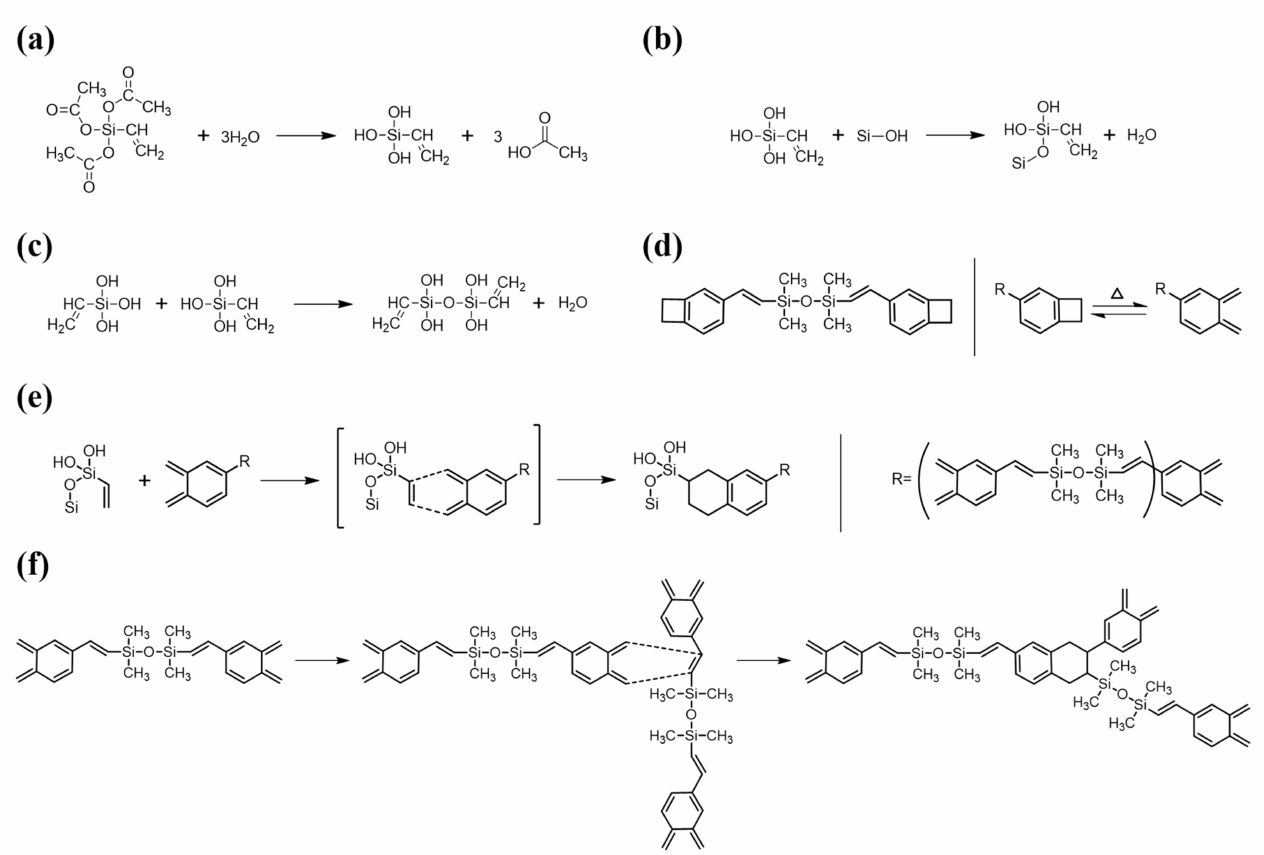
Figure 2. Reaction mechanism of AP 3000 and DVS-BCB during curing process. ( a ) Hydrolysis reaction of AP 3000, ( b ) Condensation reaction between hydrolyzed AP 3000 and silicon wafer surface, ( c ) Condensation reaction between hydrolyzed AP 3000s, ( d ) Chemical structure of DVS-BCB and ring-opening reaction of cyclobutene by heat, ( e ) Diels-Alder reactions between the vinyl group of hydroxylated AP 3000 (dienophile) and o-xylylene of DVS-BCB (diene), ( f ) Diels-Alder reactions between the vinyl group of DVS-BCB (dienophile) and o-xylylene of DVS-BCB